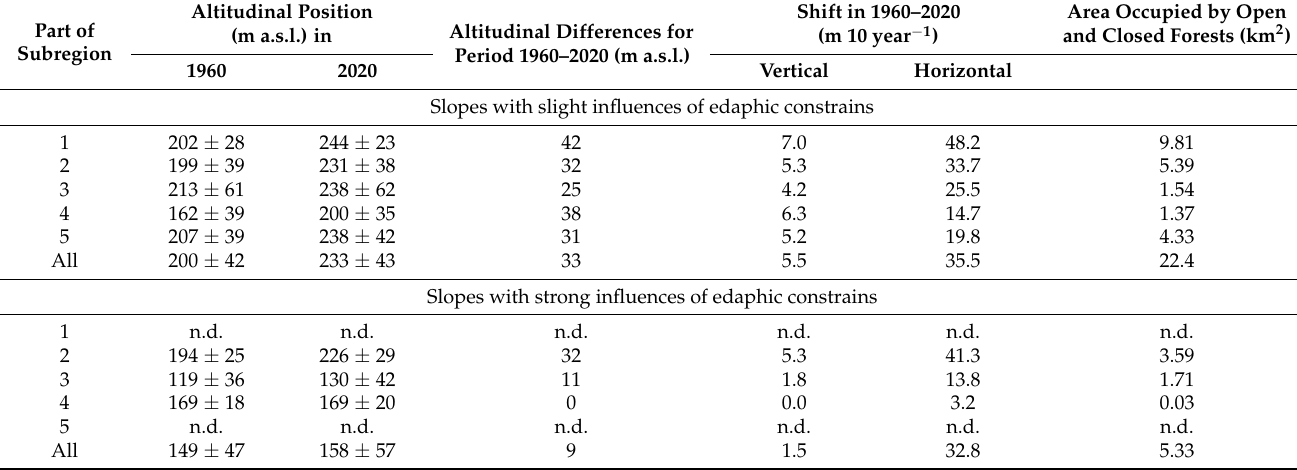
Table 6. Altitudinal position and shift in the open forest boundary (mean ± SD) at different parts of the studied subregion of the Polar Urals in 1960 and 2020, and the area occupied by open forests over the 60-year period.